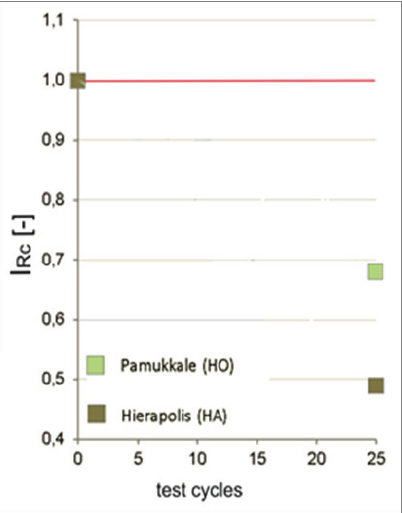
Fig. 5. Strength reduction index I Rc after the impact of temperature oscillations (insolation)